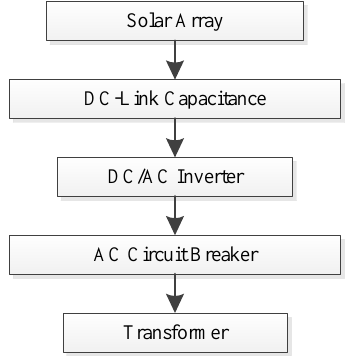
Figure 7. Functional block diagram of a central PV system.